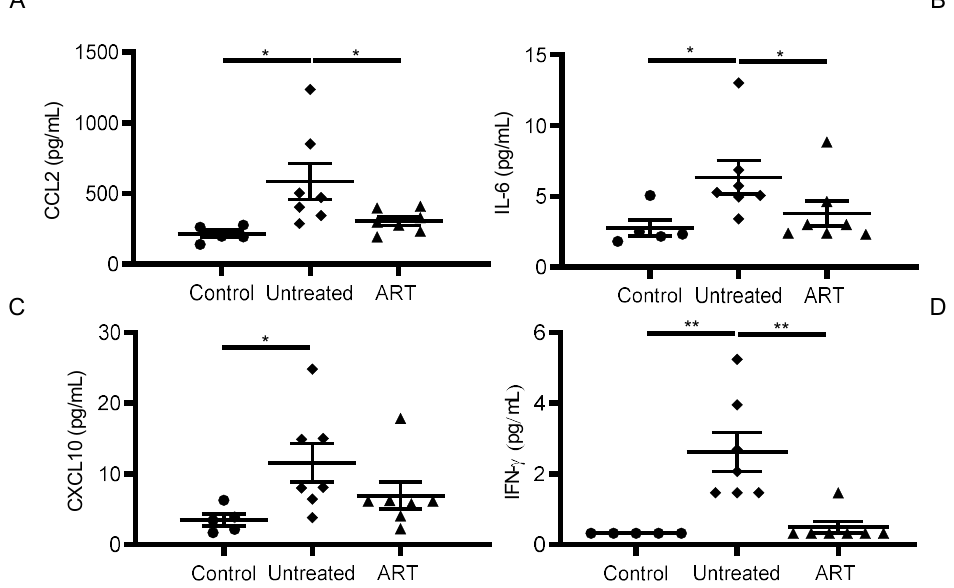
Figure 2. Differential cytokine and chemokine levels in CSF of chRMs. The scatter graphs show the distribution observed in the CSF of the experimental groups for the cytokines ( A ) CCL2, ( B ) IL-6, ( C ) CXCL10, and ( D ) IFN-g. (* p < 0.05, ** p < 0.01). Non-parametric Mann-Whitney tests.